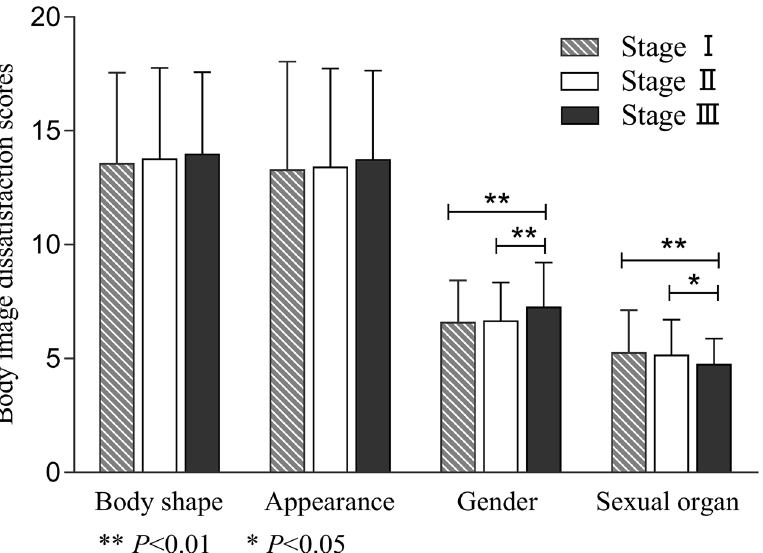
Figure 2. The comparison of body image dissatisfaction scores among puberty developmental